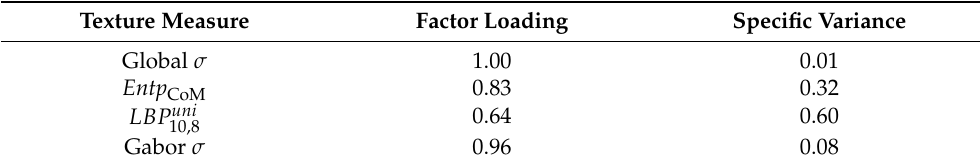
Table 2. The results of the factor analysis on the computed global σ , Entp CoM , LBP uni of the sRGB intensity images of the